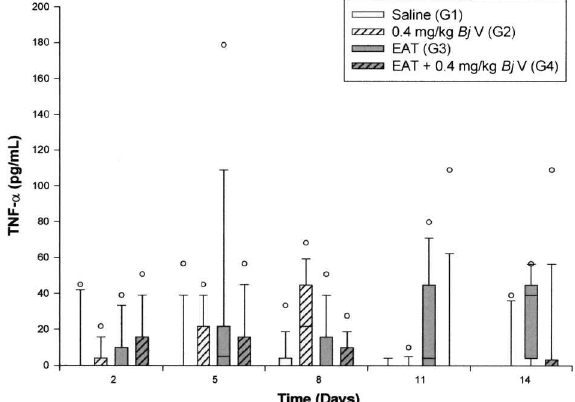
FIG. 4. Box plot of the IL-13 level kinetics in EAT cells treated with Bj V. Each box represents 25–75% values with the median as an internal line, the error bar represents 10% and 90%, and the circle represents the outliers. Statistics: 2nd day, G4 > G1; 11th day, G2 > G1; 14th day, G2 > (G1 = G3), G4 > G1; p < 0.05.